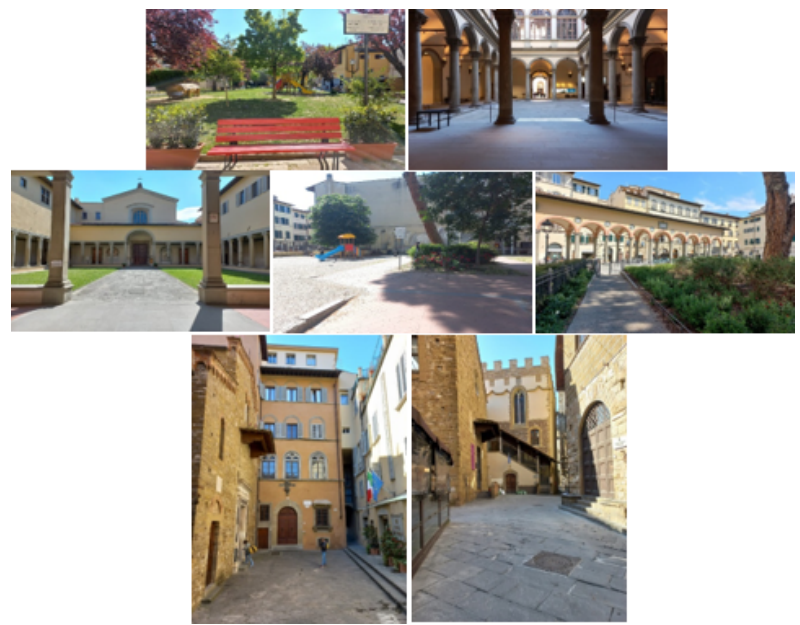
Figure 2: Pictures of the selected case studies (from the top-left to the bottom-right: GBA, CPS, CCMM, GG, PC, PL, PPG)